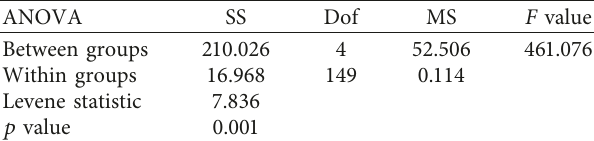
Table 5: ANOVA test between support in forecasting patterns and application of blockchain technology in treating patients.